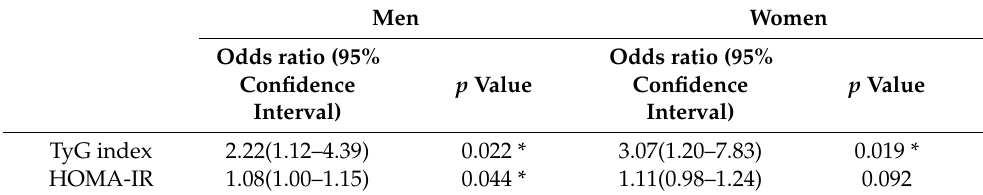
Table 4. Odds ratios of multivariate logistic regression model for predicting IR.